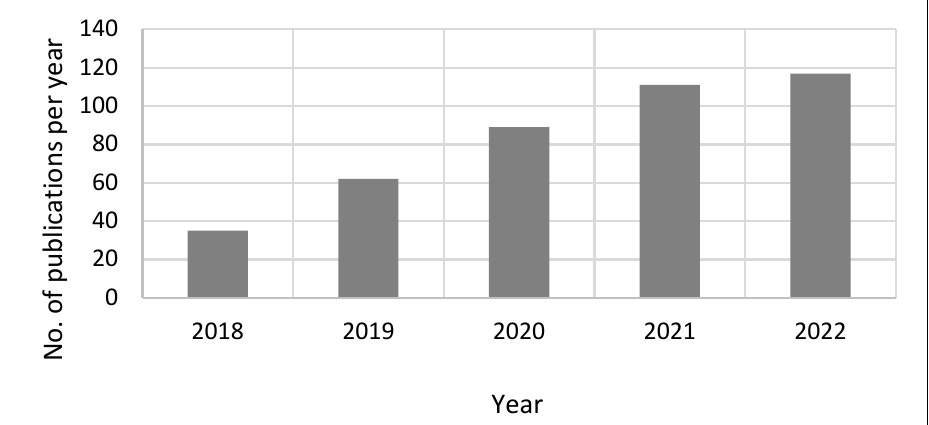
Figure 1. Year-wise Publications—Additive manufacturing of Inconel 625 (Web of Science). Laser-directed energy or direct laser deposition (DLD) can be used for single or multi- material deposition for repair, cladding, or producing large-volume parts. DLD is defined as a “process in which focused thermal energy of the laser melts the material being